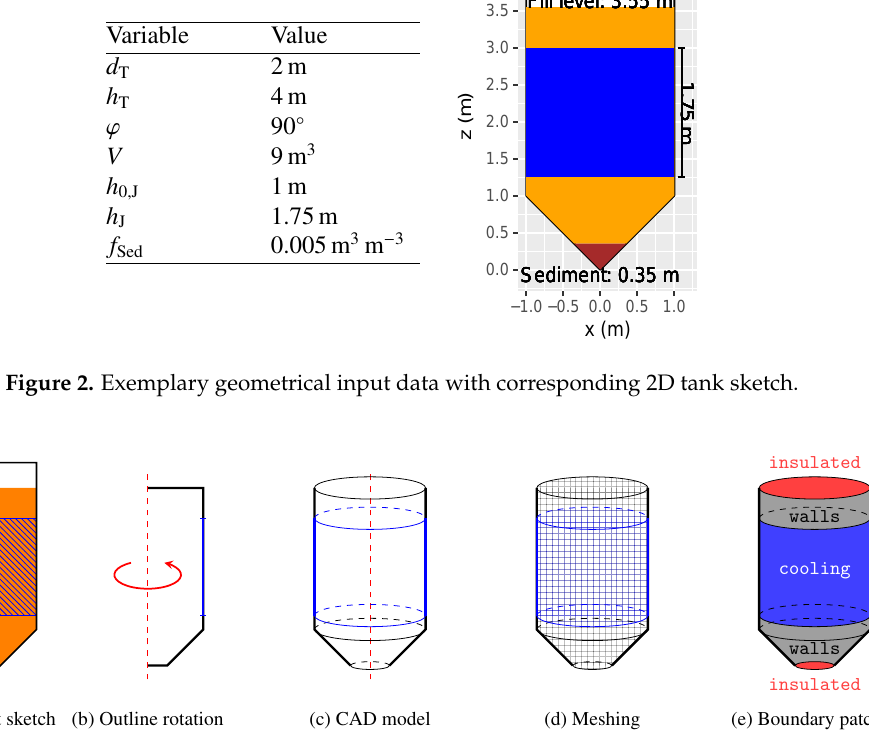
Figure 3. Five steps ( a – e ) of the fully automated mesh generation